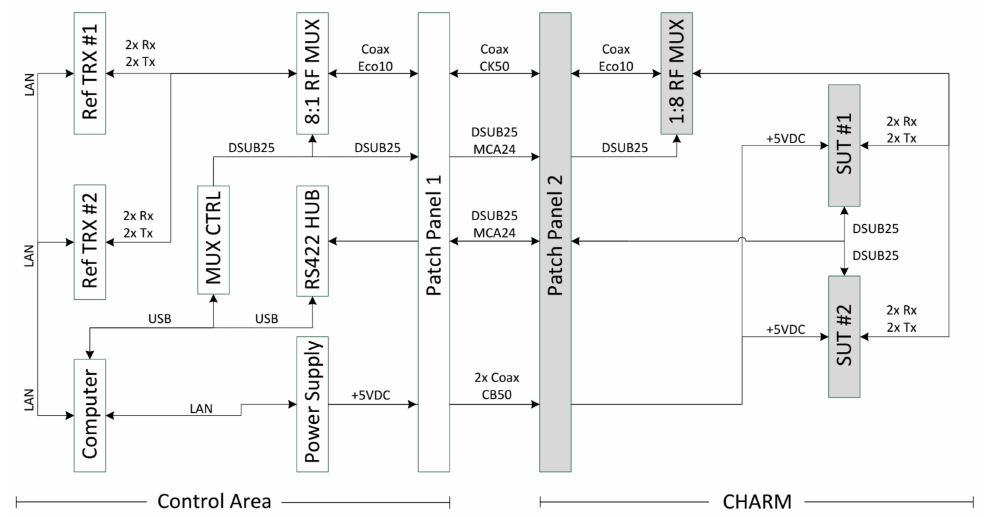
Figure 4. Schematic of the GSDR test